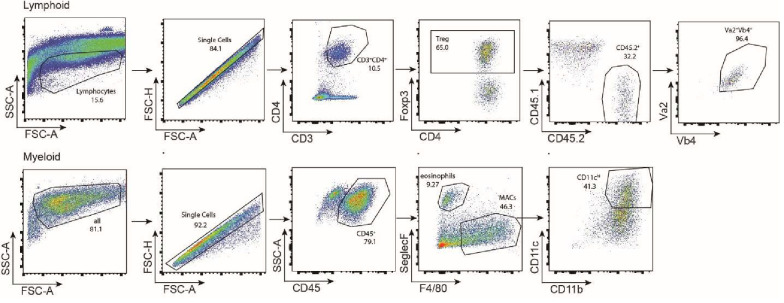
Gating strategy.Gating strategy used for detection of VAT Treg cells (top) and, eosinophils or macrophage cells (bottom) by flow cytometry.